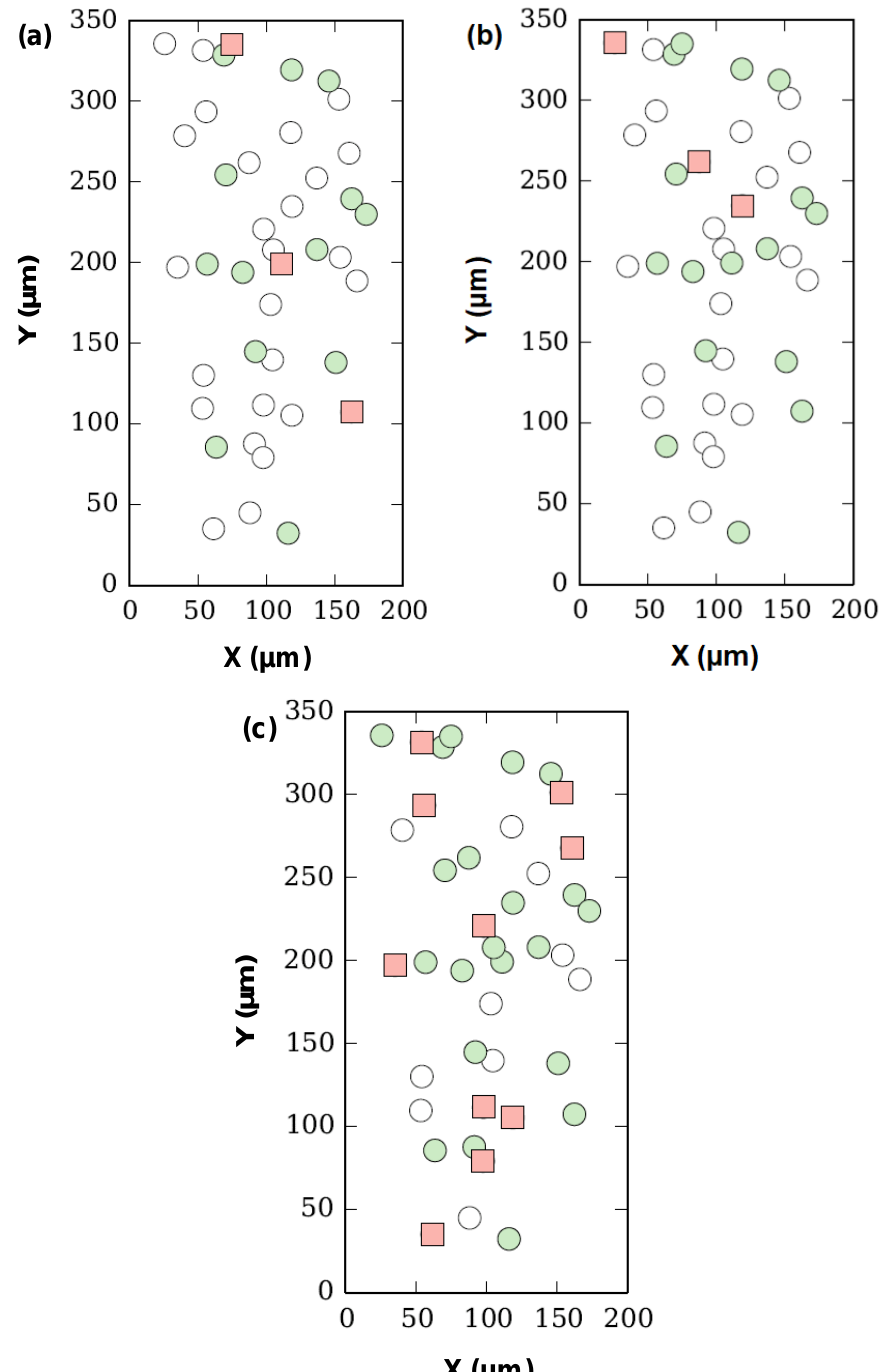
Figure 8. Graphical representation of the relative position of centroids of SiC particles on a projected XY plane when ( a ) Traction is 337.5 MPa, ( b ) Traction is 360 MPa, and ( c ) Traction is 405 MPa. Solid circles in white represent particle centroids that are not cracked. Green circles and red squares are particle centroids that are "previously" cracked and "newly" cracked, respectively, relative to the previous load step.